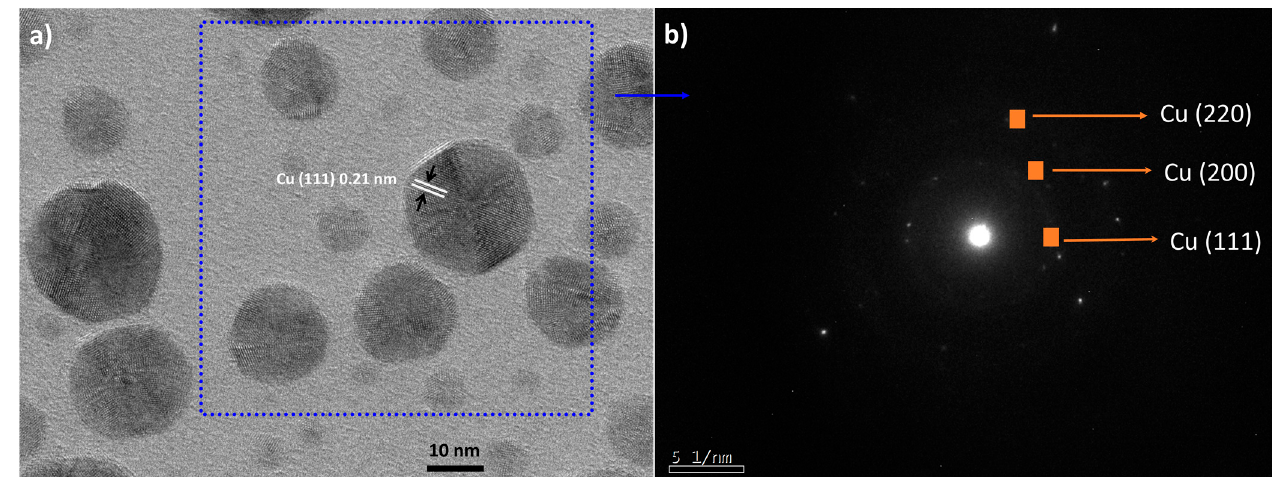
Figure 2. ( a ) High-resolution micrograph of copper nanoparticles obtained by DARC-AC and ( b ) selected area electron diffraction (SAED) of CuNPs.